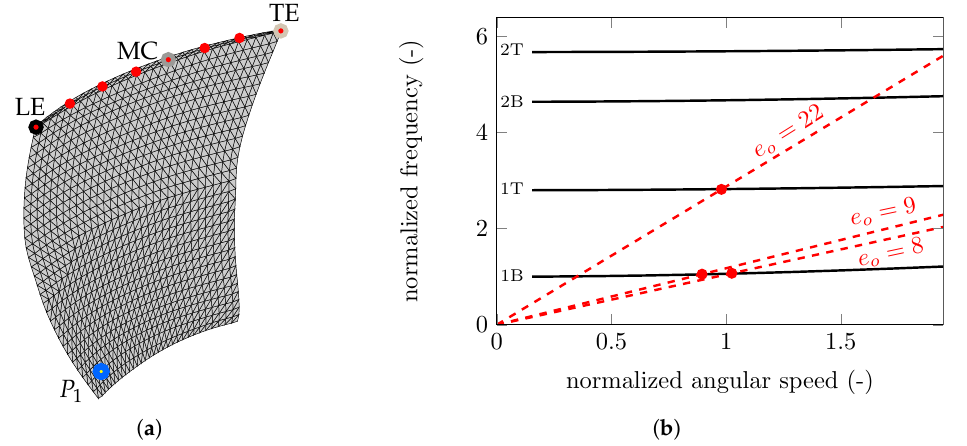
Figure 4. Finite element model ( a ) and Campbell diagram ( b ) of the HP compressor